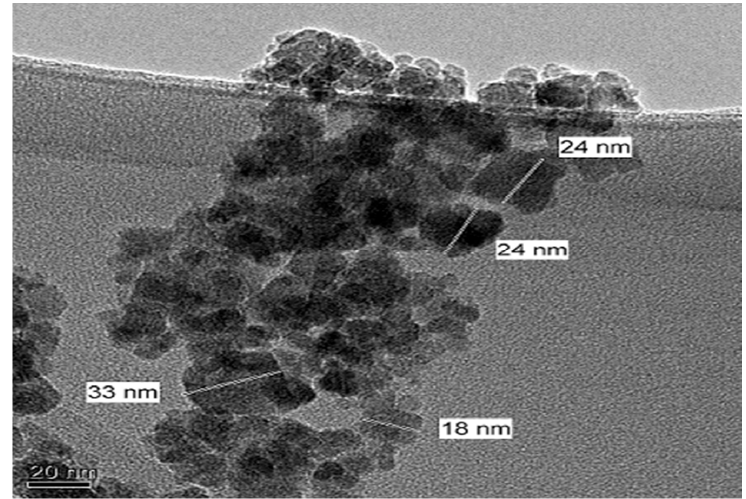
Figure 2. High-Resolution Transmission Electron Microscope image of rGONF (Scale bar is 20 nm).